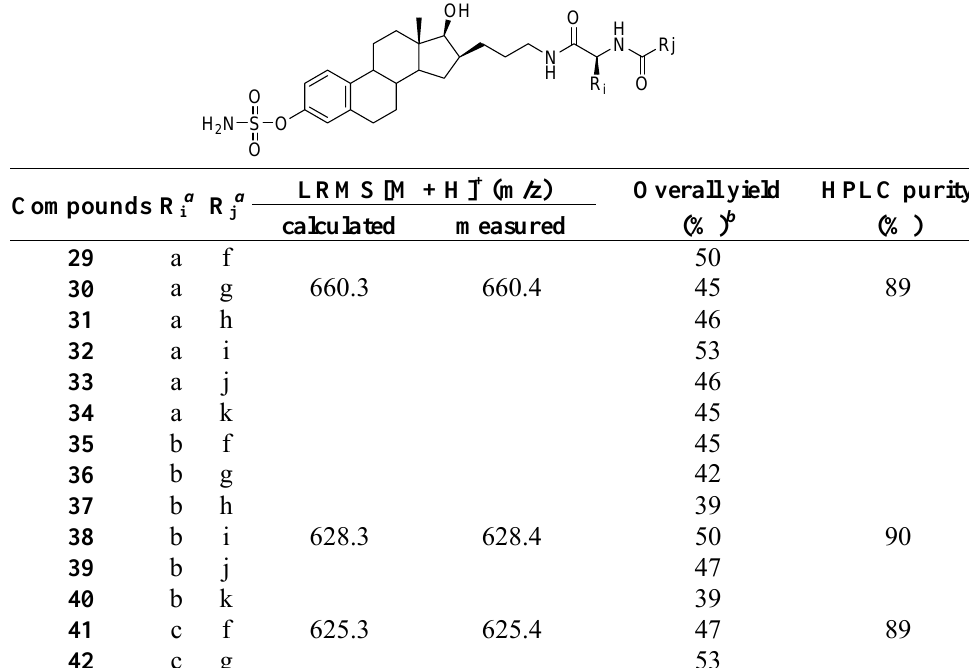
Table 1. Characterization of members from library A (sulfamoylated E